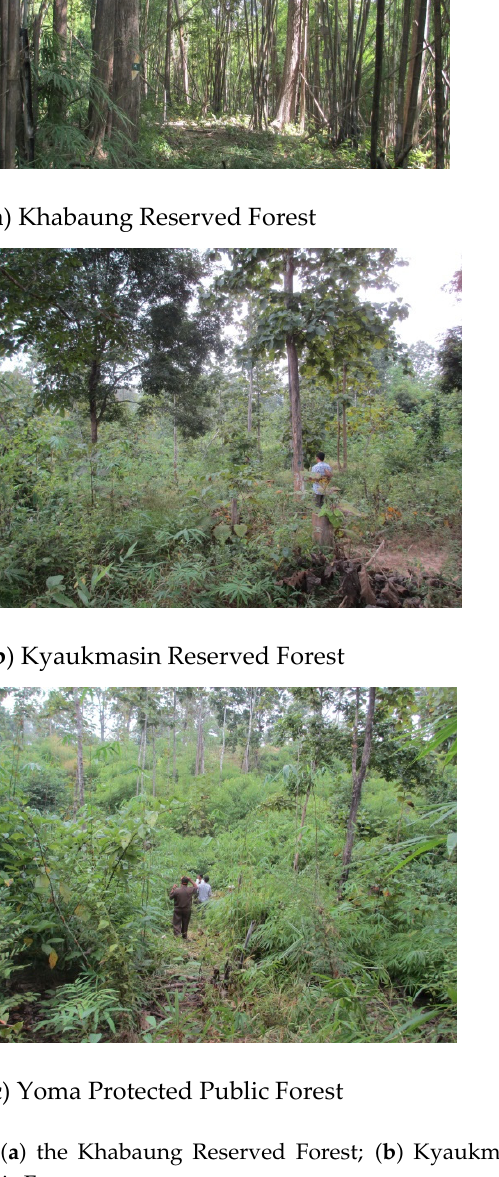
Figure 2. Photographs of ( a ) the Khabaung Reserved Forest; ( b ) Kyaukmasin Reserved Forest; and ( c ) Yoma Protected Public Forest.